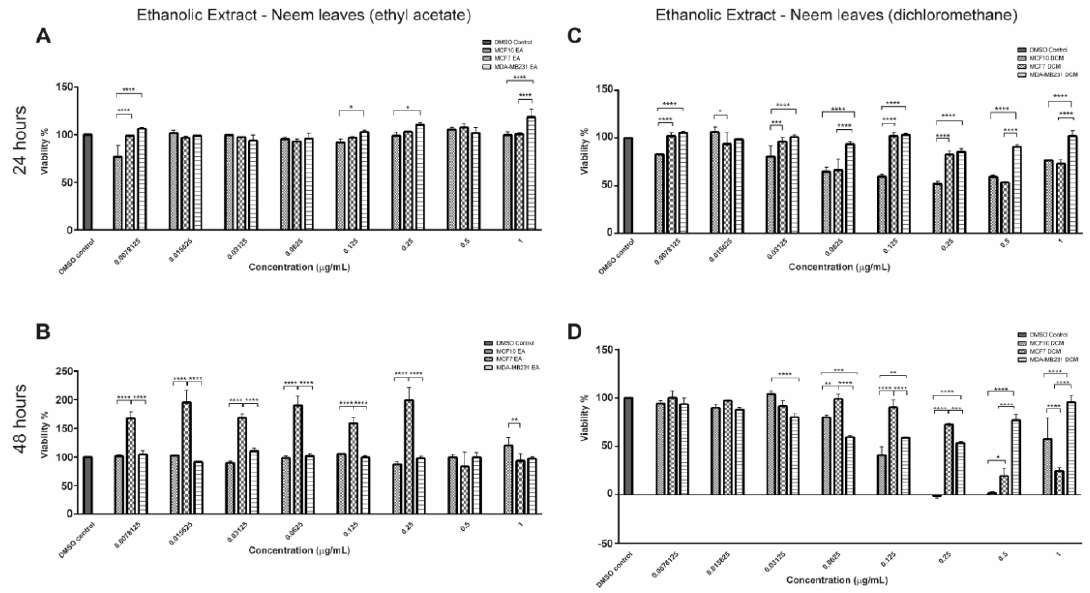
Figure 1. Effect of Ethanolic Extract of Neem Leaves (EENL) prepared from A. indica on breast cells (MCF 10A, MCF7, and MDA-MB-231) proliferation. ( A , B ) Treatment with EENL obtained with Ethyl Acetate (EENL–EA) extract for 24 and 48 h, respectively. ( C , D ) Treatment with EENL extract obtained using dichloromethane (EENL–DCM) for 24 and 48 h respectively. * P < 0.05, ** P < 0.01, *** P < 0.001 and **** P < 0.0001.